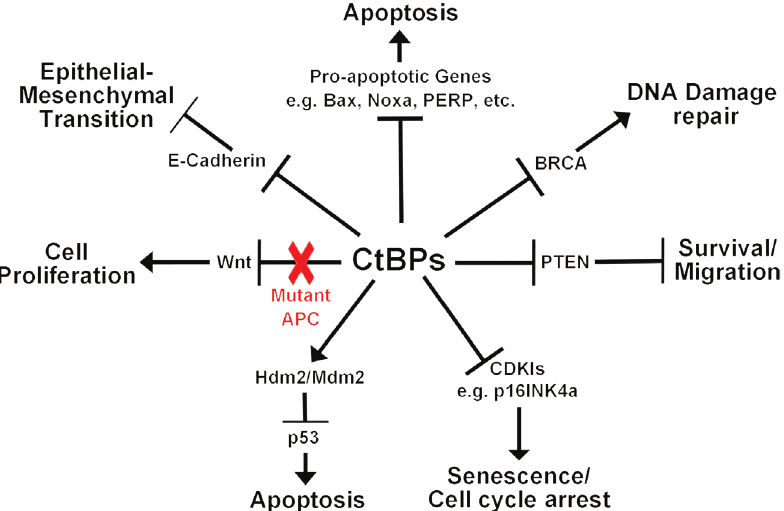
Figure 6 Dysregulation of CtBPs as a common pathological link in neurodegenerative disease and cancer. CtBPs function to promote cellular survival through repression of pro-apoptotic (e.g., Bax, p53) and pro-anoikis (e.g., E-cadherin) gene pro- gramming. Typically, CtBPs suppress Wnt-dependent cell proliferation except in the case of mutant APC. CtBPs diminish DNA damage repair and cell cycle arrest. Finally, CtBPs enhance cell survival and migration through repression of PTEN. Thus, diminished expression of CtBPs may underlie aberrant neuronal apoptosis neurodegenerative disease, whereas enhanced CtBP expression may promote carcinogenesis by inhibition of apoptosis and stimulation of proliferation, migration, survival, and genomic